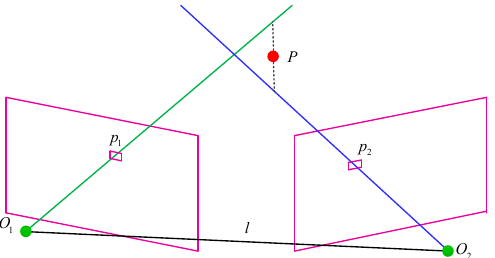
Figure 5. Schematic representation of the triangulation depth recovery.